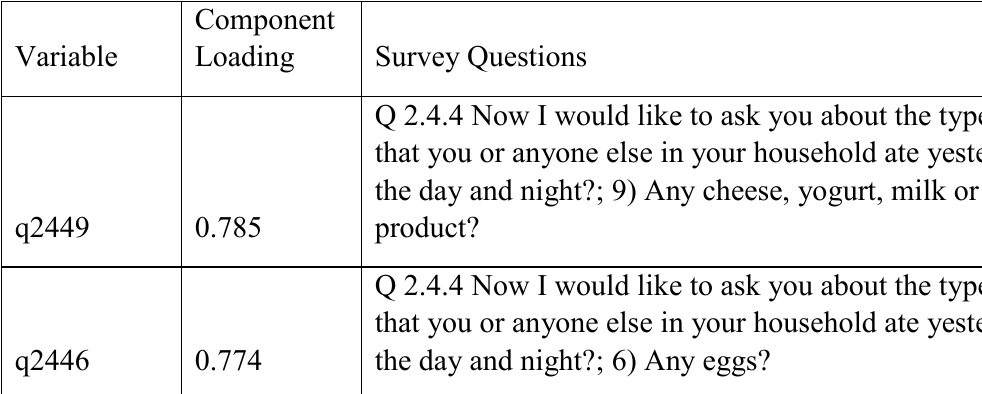
Table 1.4: Variables defining Absorptive Resilience PC2